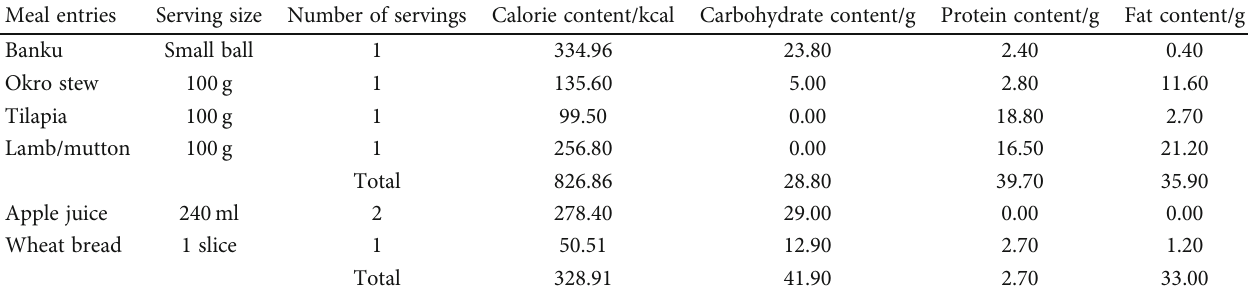
Table 10: Sample predicted